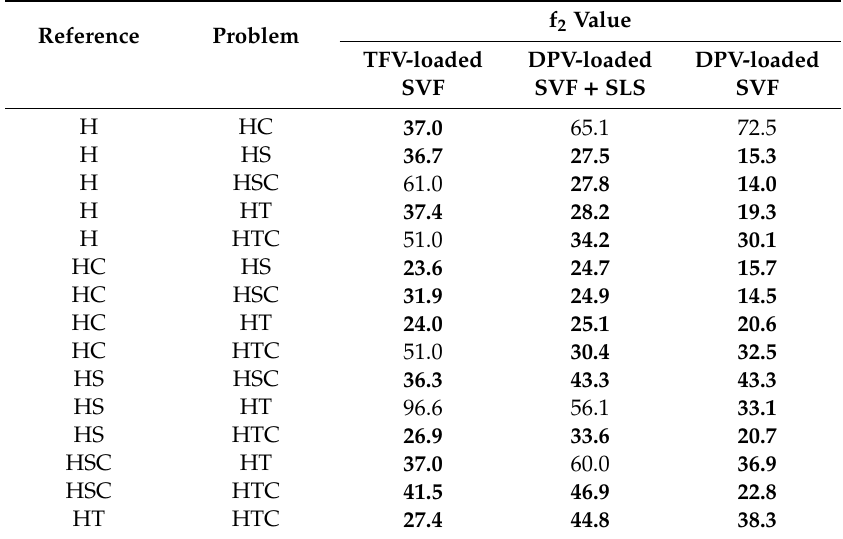
Table 3. Similarity factor (f 2 ) values obtained from the comparison of batches. Significant di ff erences are in